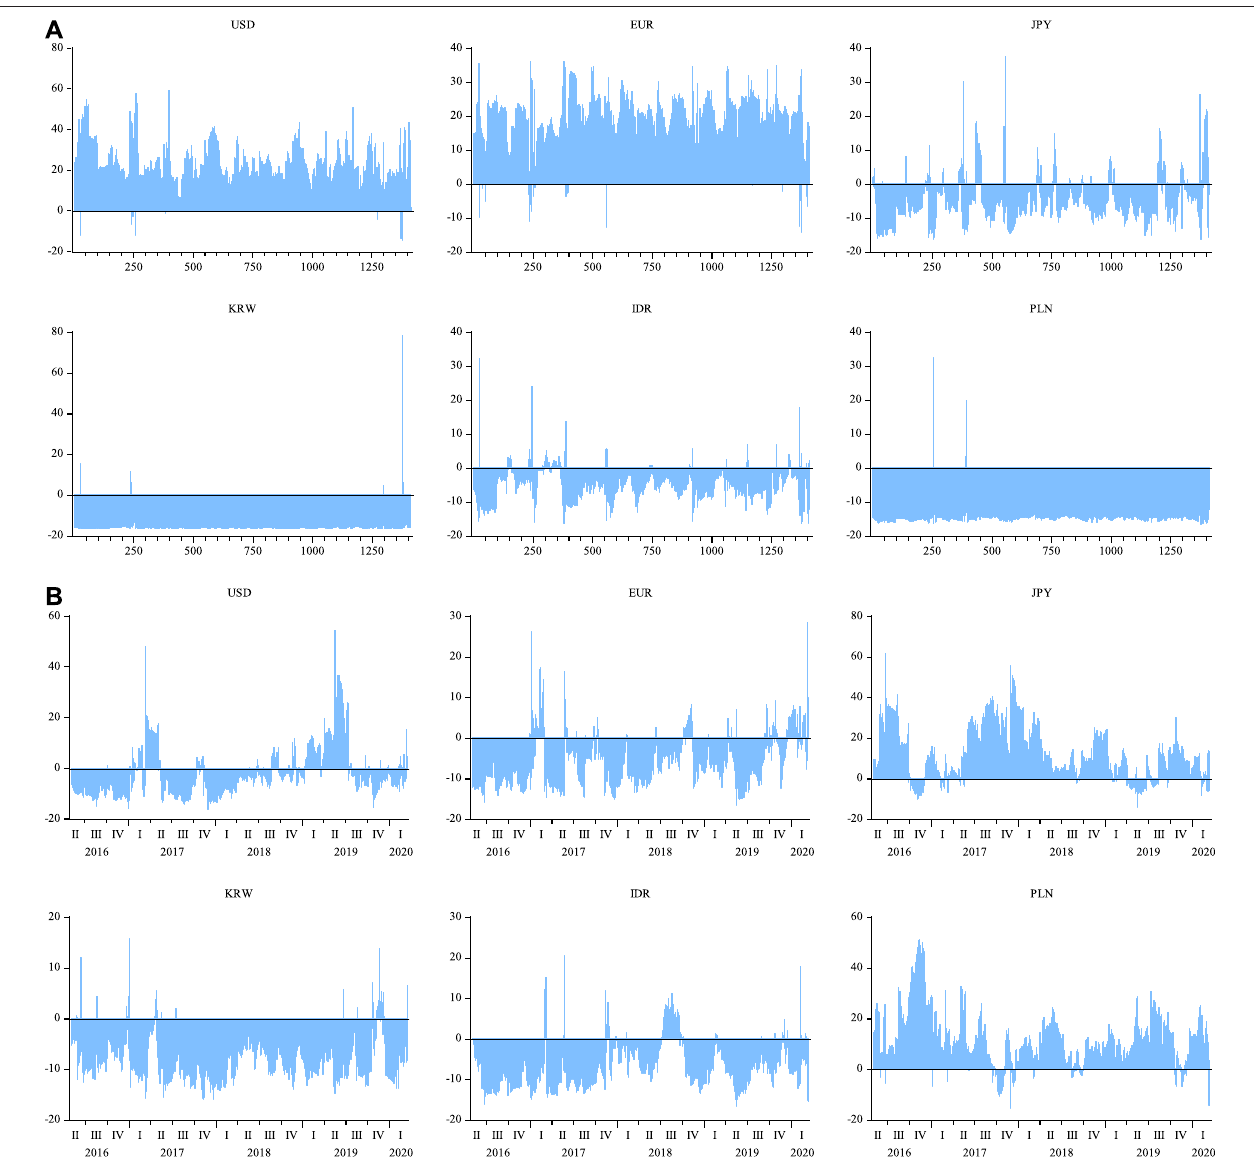
FIGURE2| DynamicnetspilloveramongdifferentBitcoin markets. (A) standsforthedynamicspilloverforsystematicvolatility; (B) reports thedynamicspilloverfor idiosyncratic volatility.